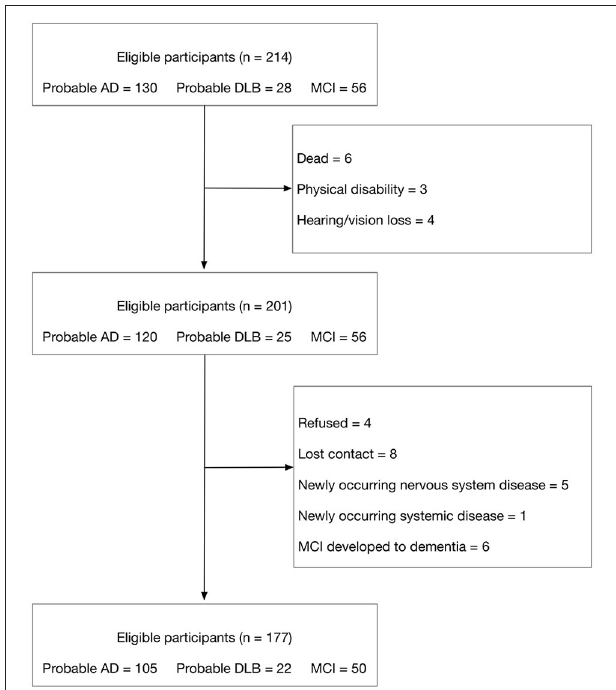
FIGURE 1 | Flow chart for inclusion and